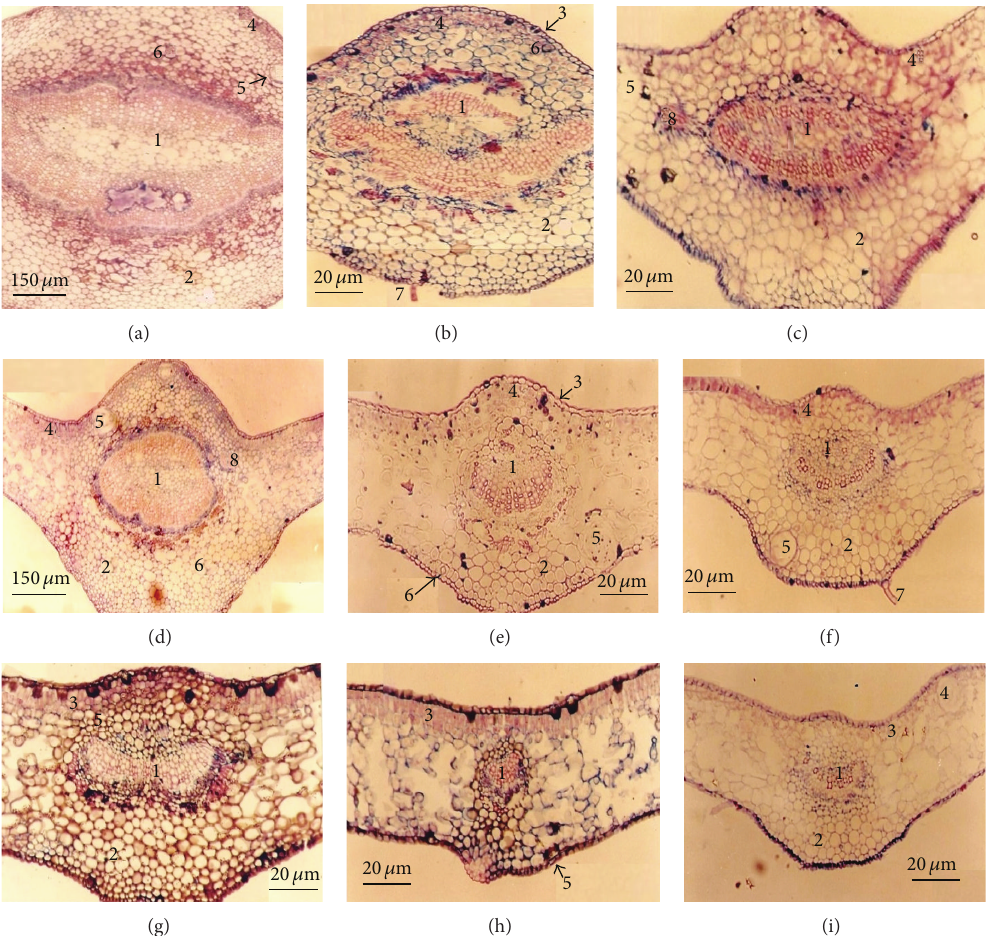
Figure 3: Histological examinations on in vivo and in vitro grown Citrus assamensis leaves. (a–c) Cross sections of leaf base of (a-b) in vivo and (c) in vitro plants, showing the presence of (1) vascular system, (2) cell structures, (3) cuticle, (4) palisade layer, (5) oil gland, (6) drusa, (7) trichome, and (8) lateral vascular bundle. (d–f) Cross sections of leaf midrib of (d-e) in vivo and (f) in vitro plants, showing the presence of (1) vascular system, (2) cell structures, (3) cuticle, (4) palisade layer, (5) oil gland, (6) drusa, (7) trichome, and (8) lateral vascular bundle. (g–i) Cross sections of leaf tip (apex) of (g-h) in vivo and (i) in vitro plants, showing the presence of (1) vascular system, (2) cell structures, (3) palisade layer, (4) oil gland, and (5)